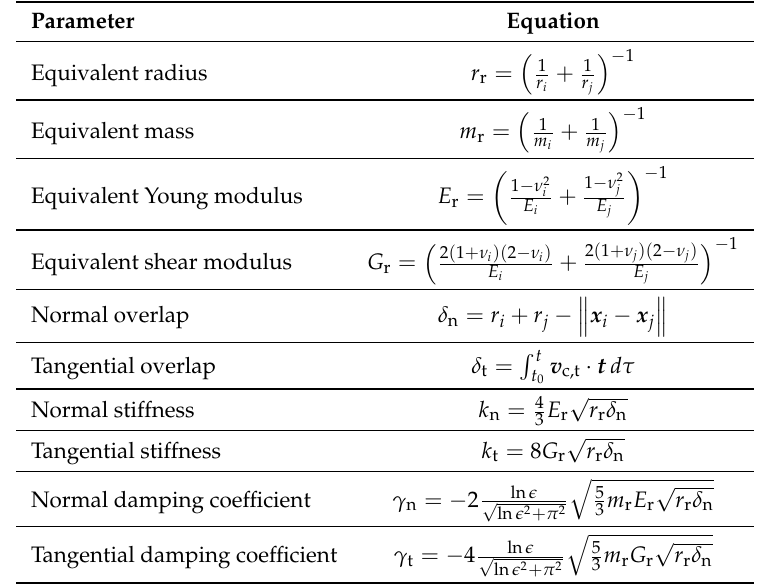
Table 1. Equations for the Discrete Element Method (DEM) model. Notice that for particle-wall interactions the equivalent radius and mass are those of the